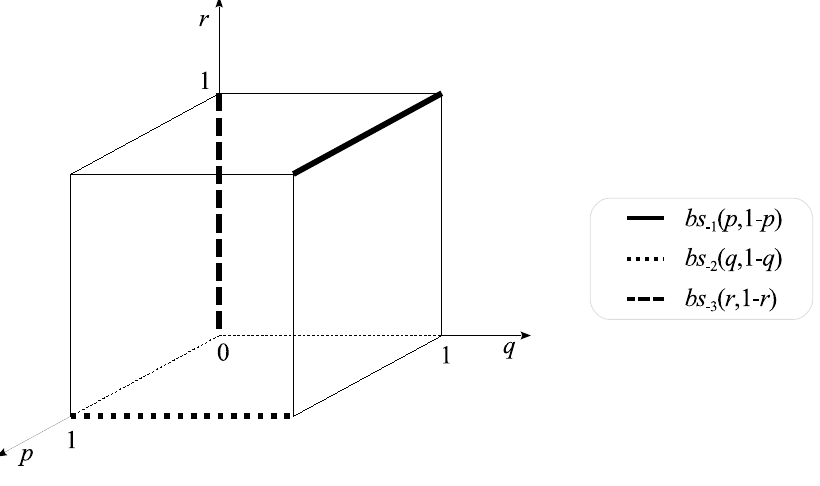
Figure 1. Best support correspondences bs i ( · ) corresponding to game